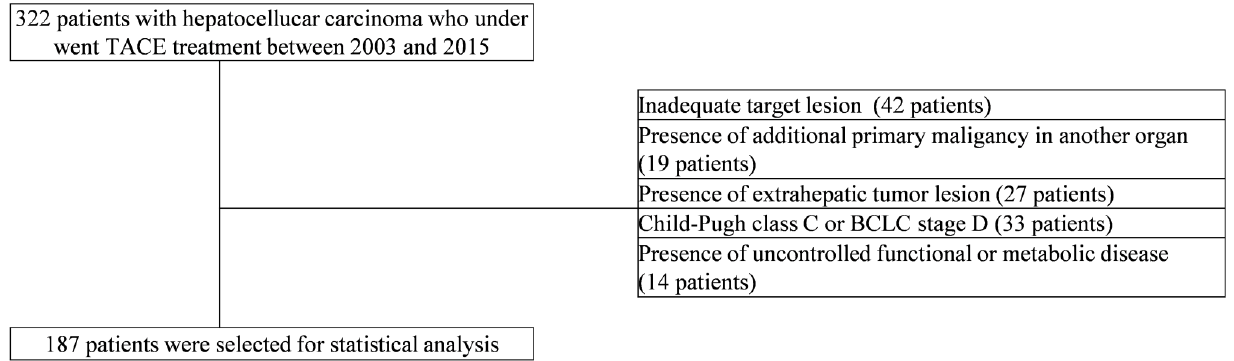
Figure 1. Flow of selecting the study population. A total of 322 patients with hepatocellular carcinoma from Yonsei University Health System who were treated with TACE between 2003 and 2015 were initially included in our study. After the exclusion of 135 patients due to our exclusion criteria, a total of 187 patients were ultimately included for the statistical analysis. TACE, transarterial chemoembolization.